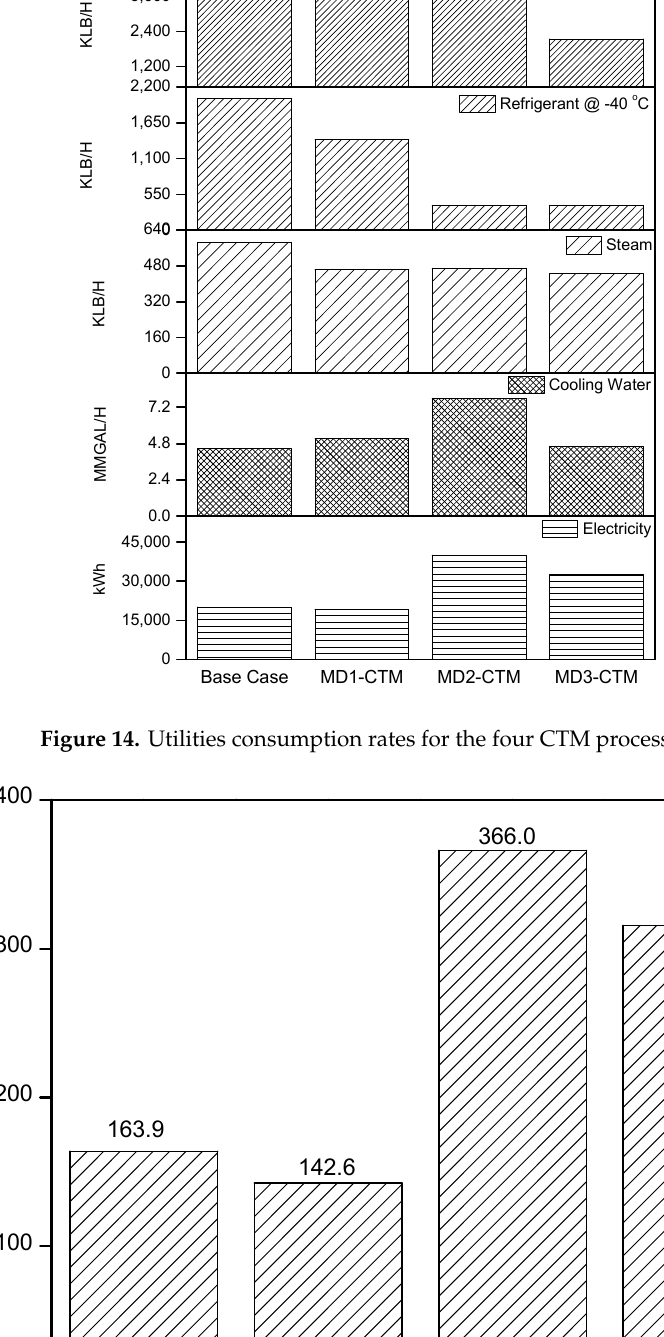
Figure 15. Methanol production cost for the four CTM processes.